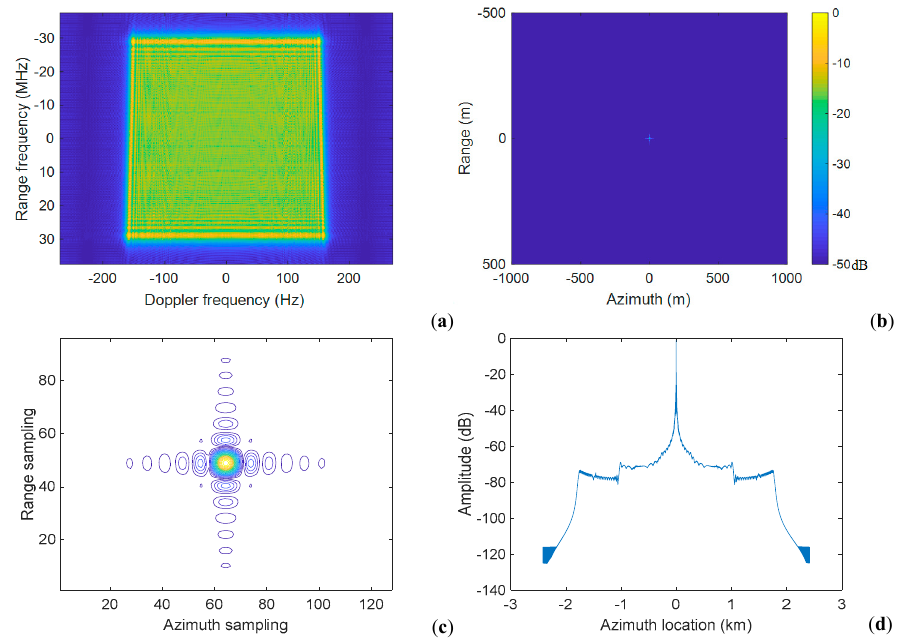
Figure 14. The imaging result via the proposed approach when the along track velocity is 10 m/s. ( a ) Reconstructed two-dimension spectrum. ( b ) The focused point target. ( c ) Contour plots of the point target. ( d ) The maximum azimuth projection profile.